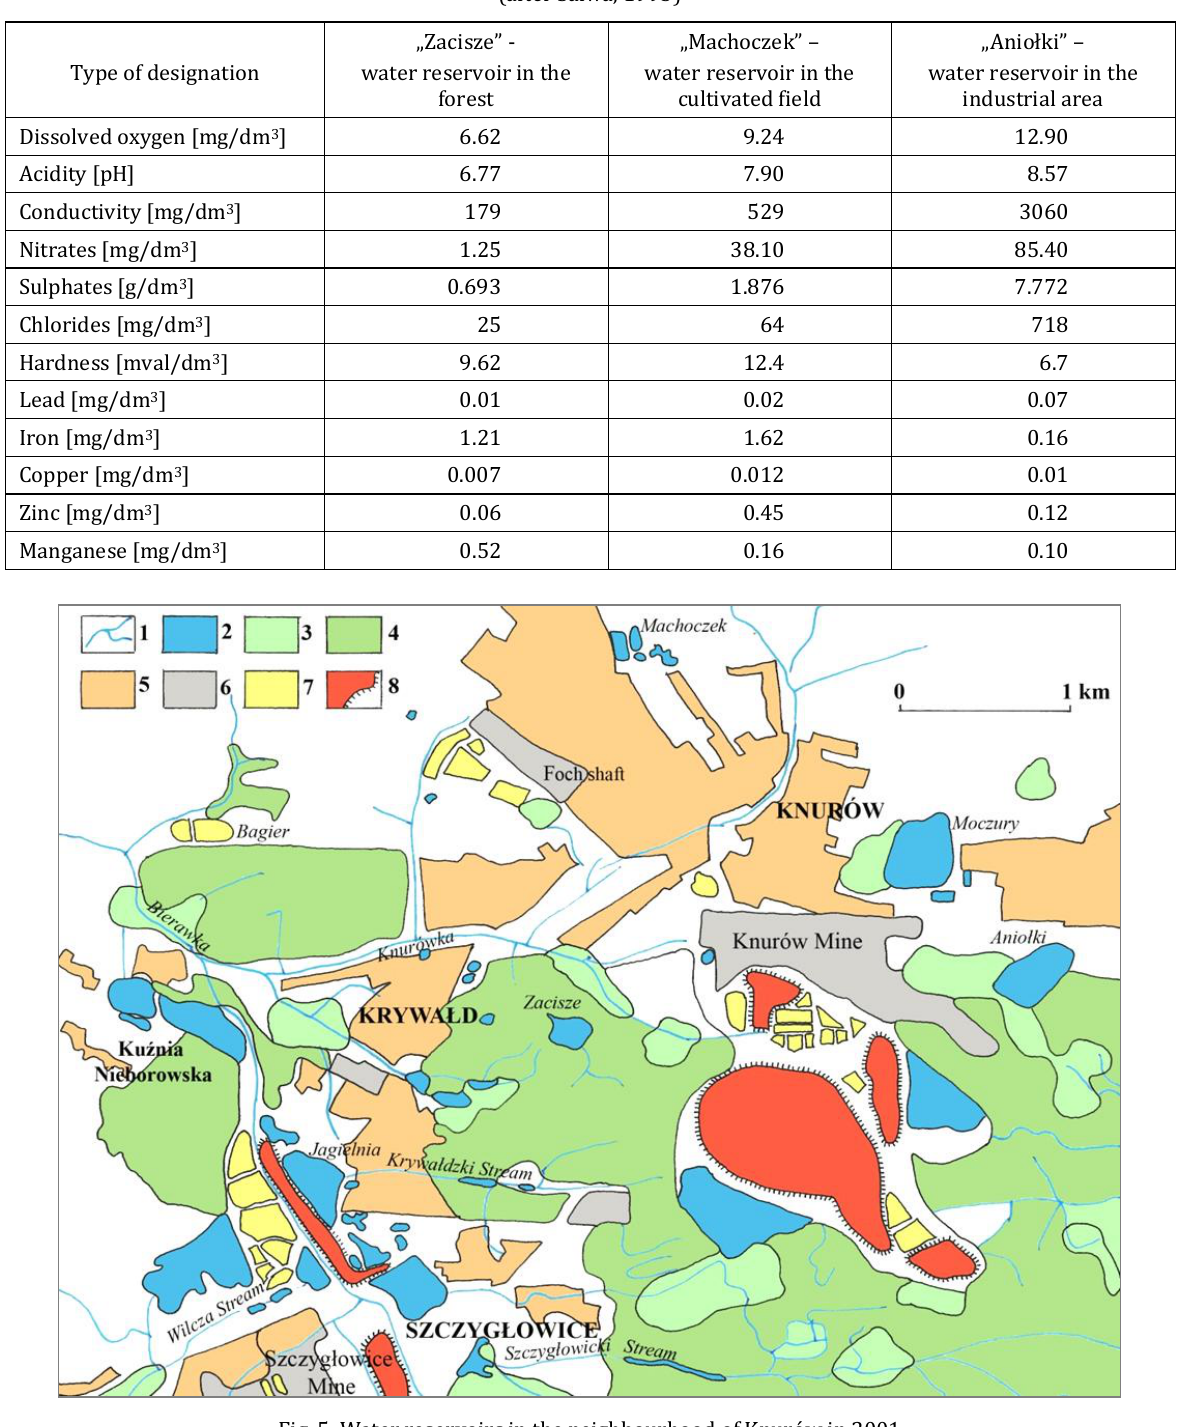
Fig. 5. Water reservoirs in the neighbourhood of Knurów in